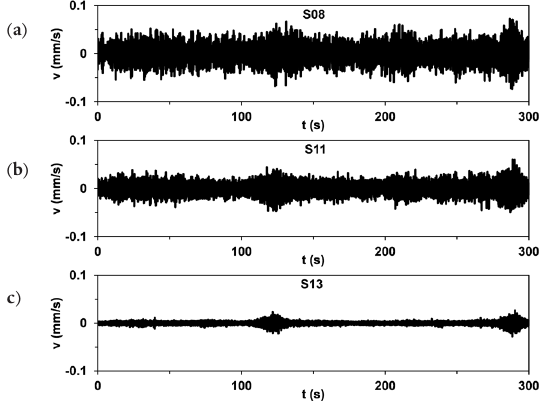
Figure 5. Time histories recorded along the first vertical alignment in configuration C1 at (a) S08, (b) S11 and (c) S13.